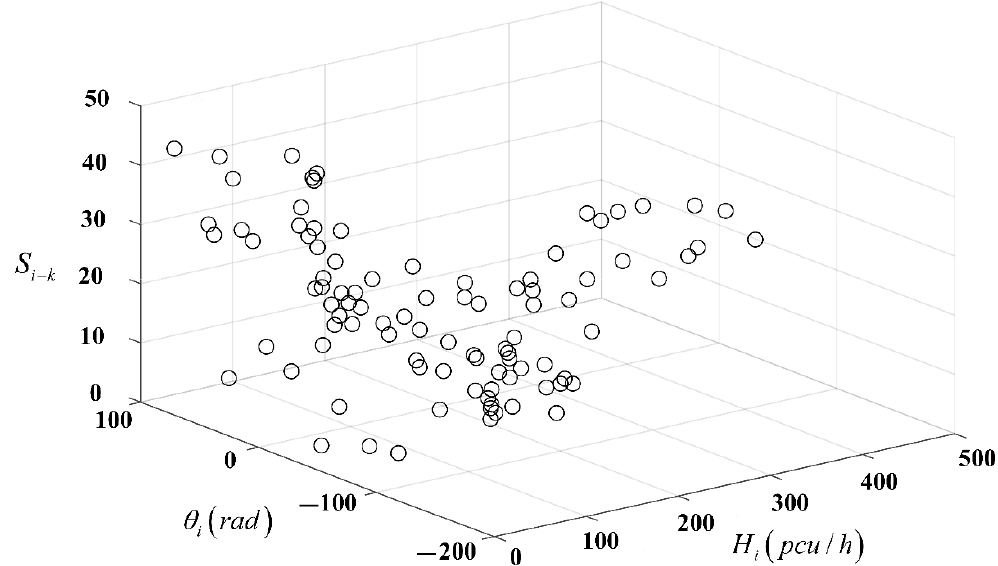
Figure 5. Traffic flow and vector distribution diagram of the entire day (Intersection at Yangming North Road and Renmin East Road on 23 June 2016 on the basis of MATLAB).